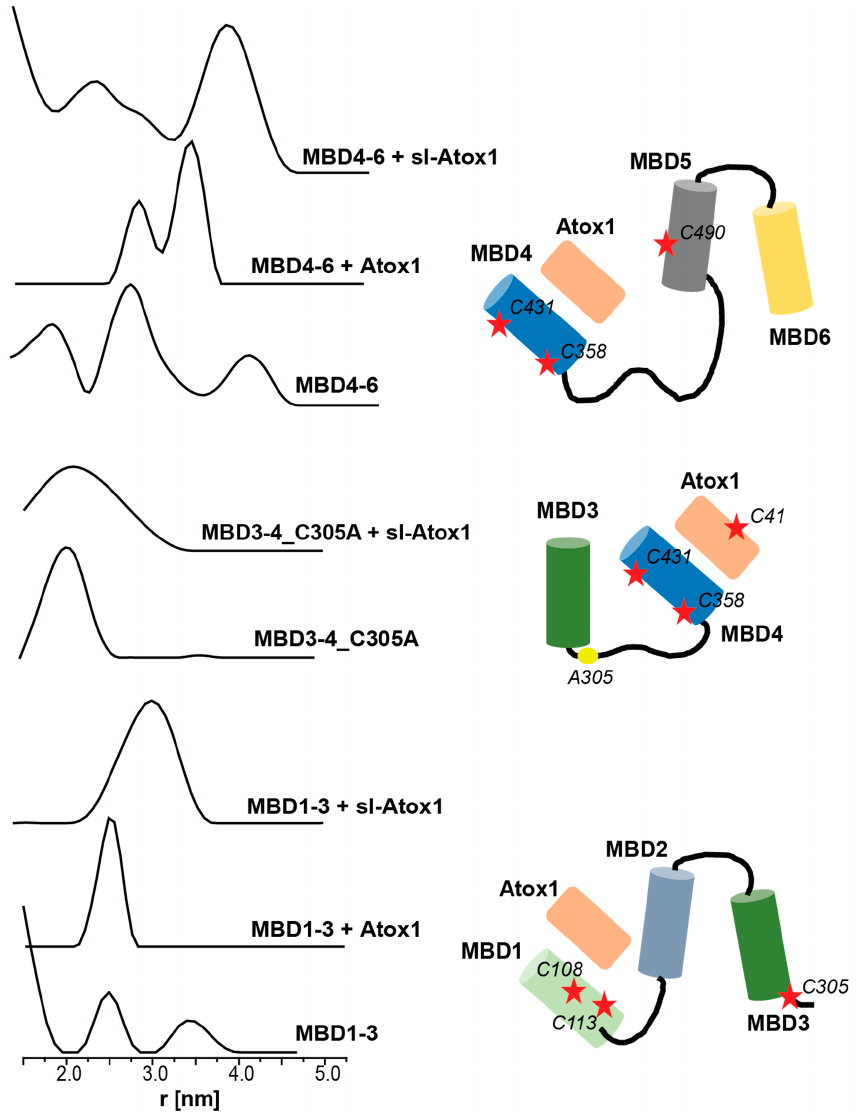
Figure 4. Double electron electron resonance (DEER) distance distribution functions for spin-labeled MBD1-3, MBD3-4_C305A and MBD4-6, in the absence and presence of Atox1 and sl-Atox1. The DEER distance distributions of MBD3-4_C305A were already reported in reference [23]. The figure also presents the spin-label positions in the various MBDs and